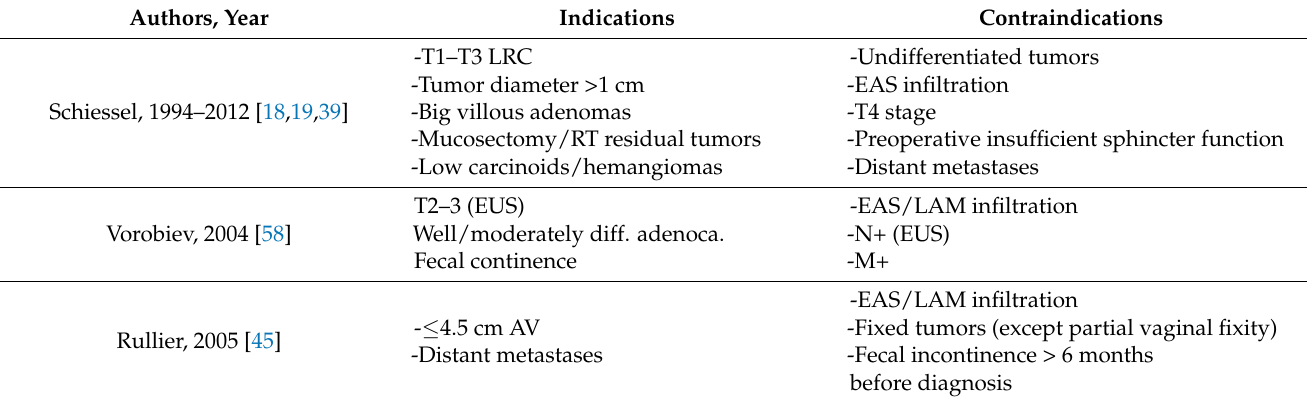
Table 1. Indications for ISR according to the